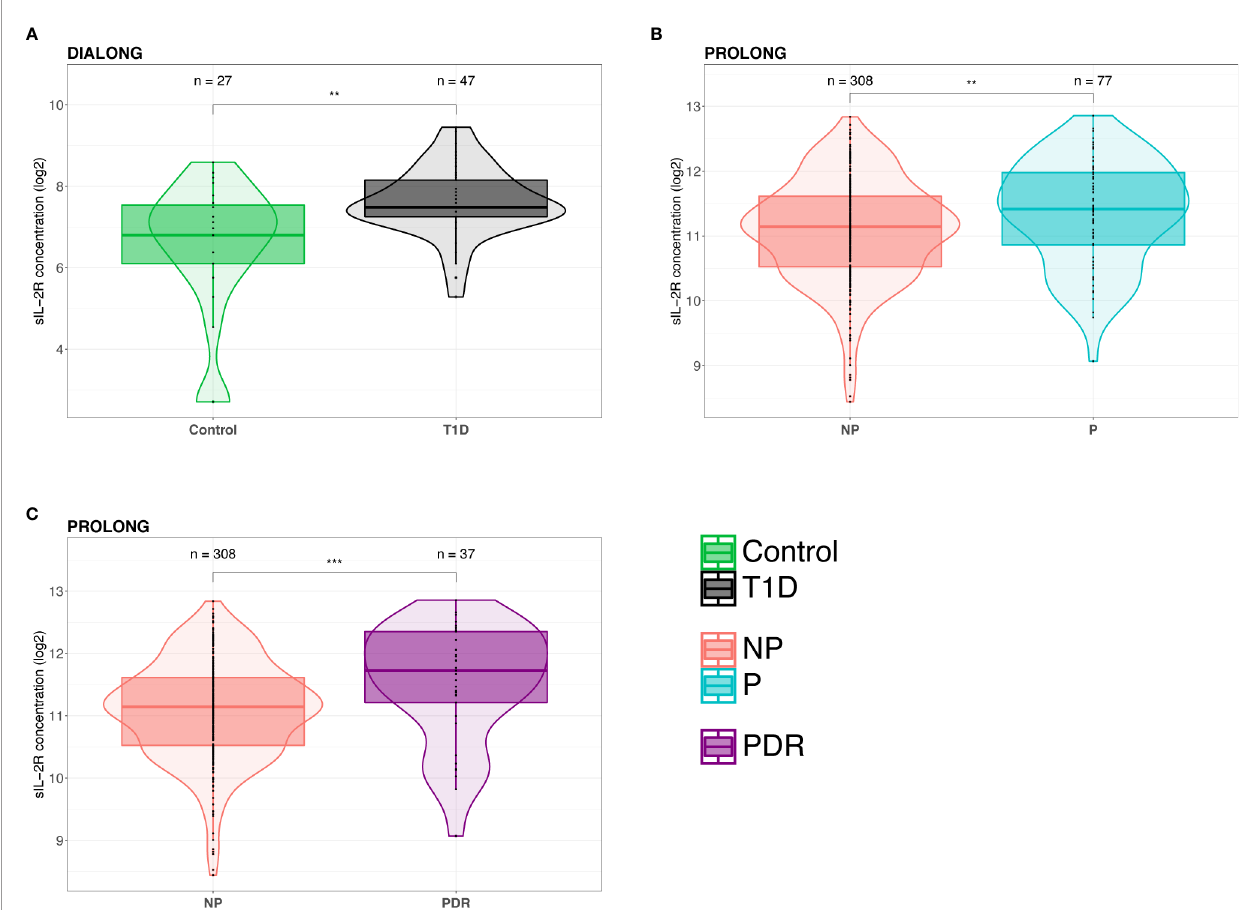
FIGURE 1 | Elevated plasma levels of sIL-2R in patients with type 1 diabetes (T1D). (A) Patients with T1D from the DIALONG cohort had signi fi cantly elevated sIL- 2R plasma levels compared to healthy controls. (B) In PROLONG, sIL-2R plasma levels were signi fi cantly increased in T1D with vascular complications (progressors, P) compared to T1D patients without complications (non-progressors, NP). (C) PROLONG progressors with proliferative diabetic retinopathy (PDR) showed signi fi cantly higher sIL-2R plasma levels compared to progressors with other vascular complications. (The Mann-Whitney U test was used in the comparison between the different groups. **p < 0.01 and ***p <